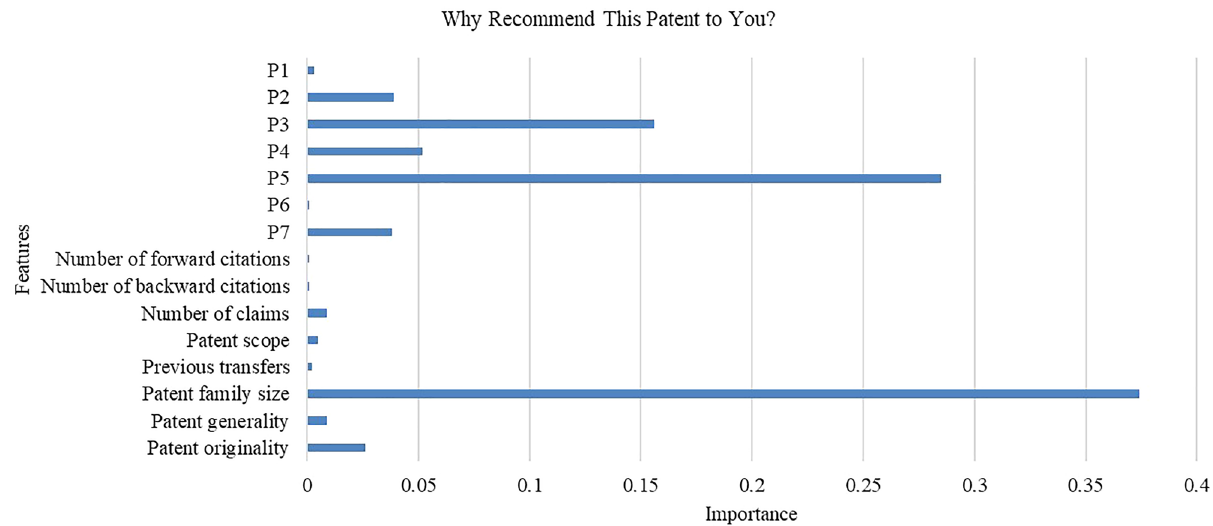
Figure 3. An illustration of the visualization